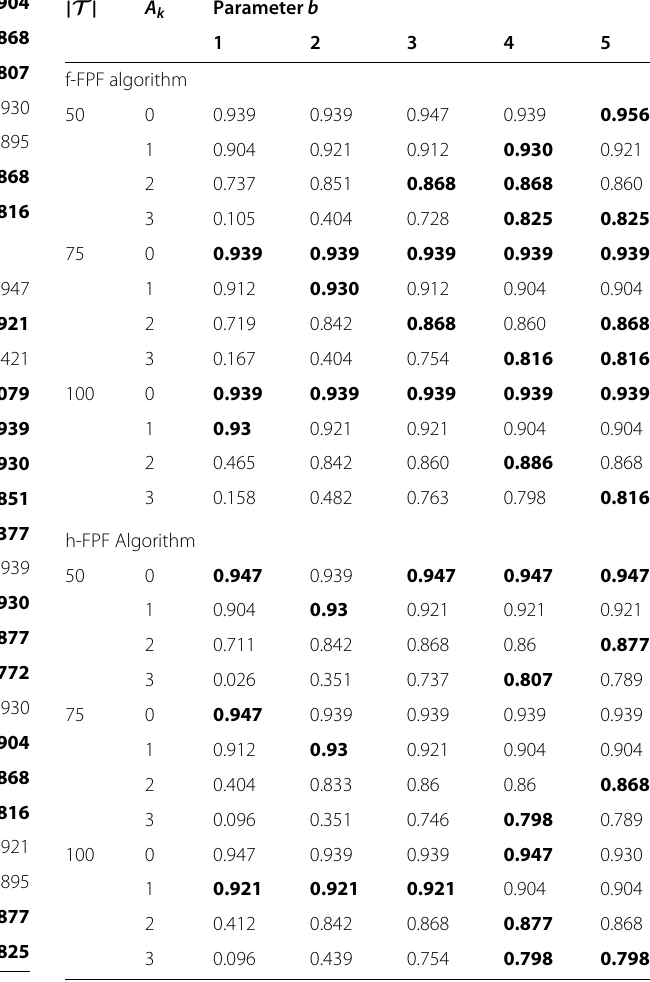
Table 6 Sensitivity analysis with respect to the